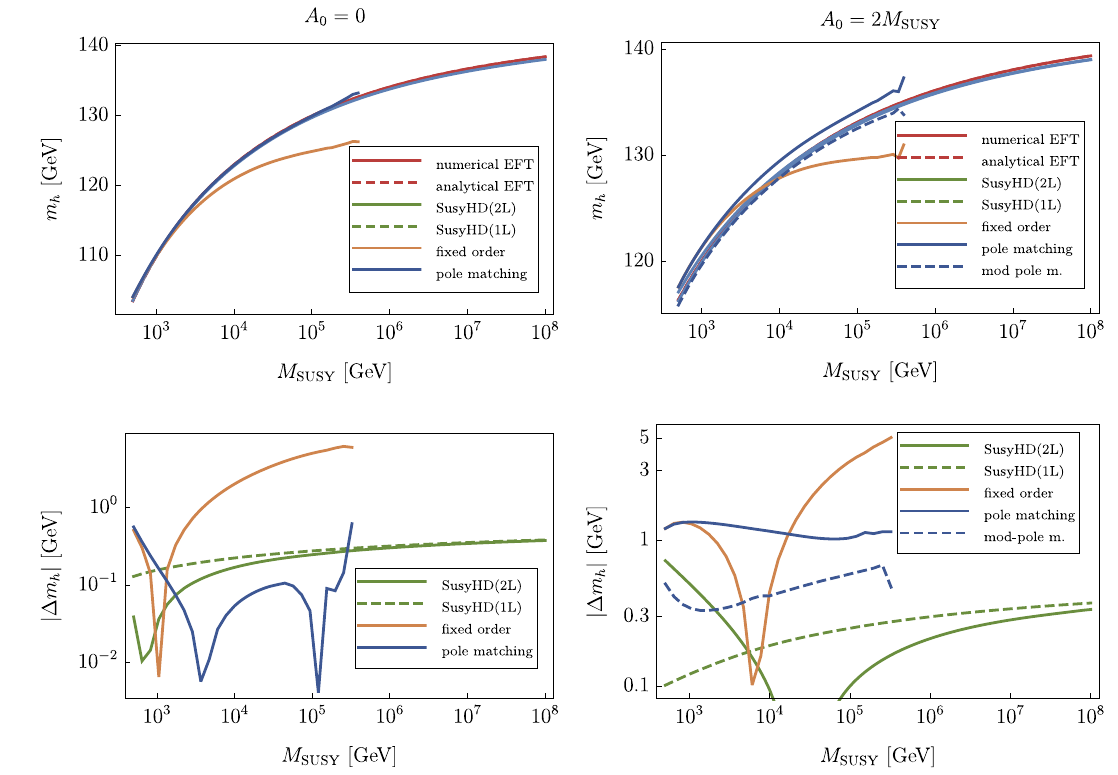
Fig. 9 Comparison between SPheno and SusyHD for high-scale SUSY as function of the SUSY scale M SUSY = m 0 = M χ = M A . Here, we used tan β = 10 and two different values of A 0 . For SPheno we give the results using the analytical and numerical approach to per- form the matching at the SUSY scale. Also the results of a fixed-order